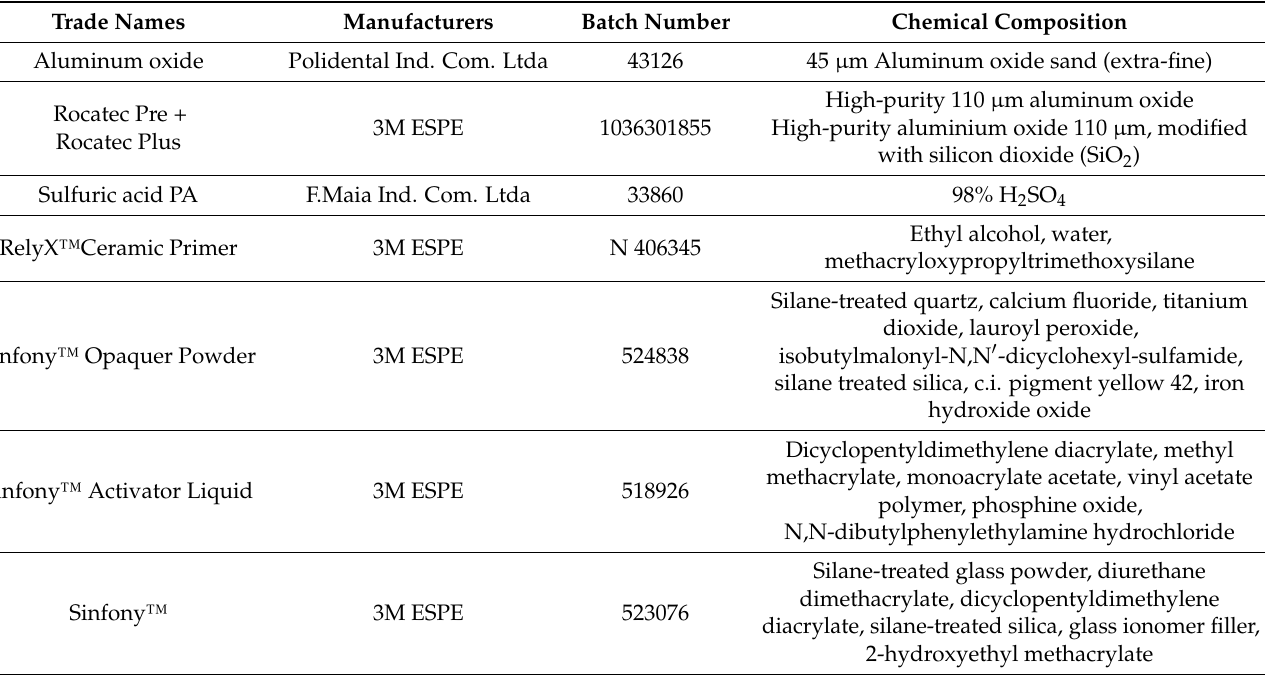
Table 1. Material